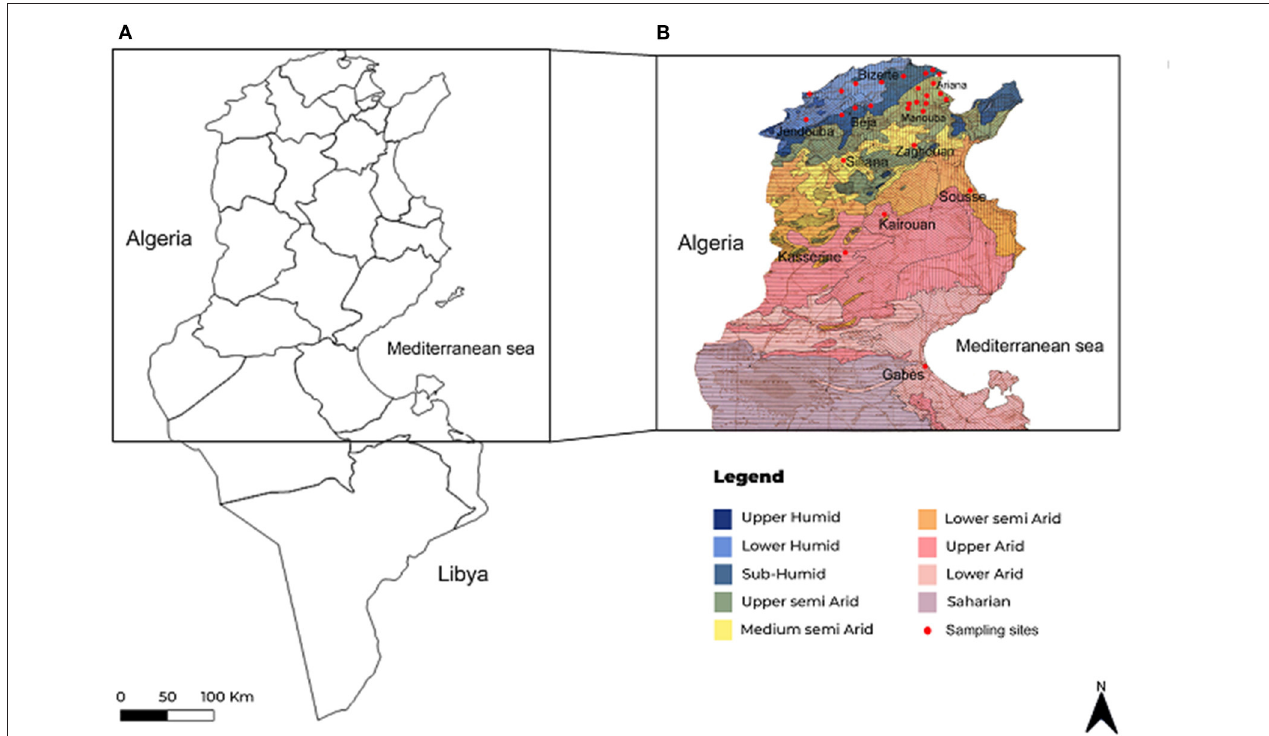
FIGURE 1 | Maps showing geographical position of studied regions in Tunisia (A) and sampling sites presented in investigated regions according to bioclimatic stages (B) .